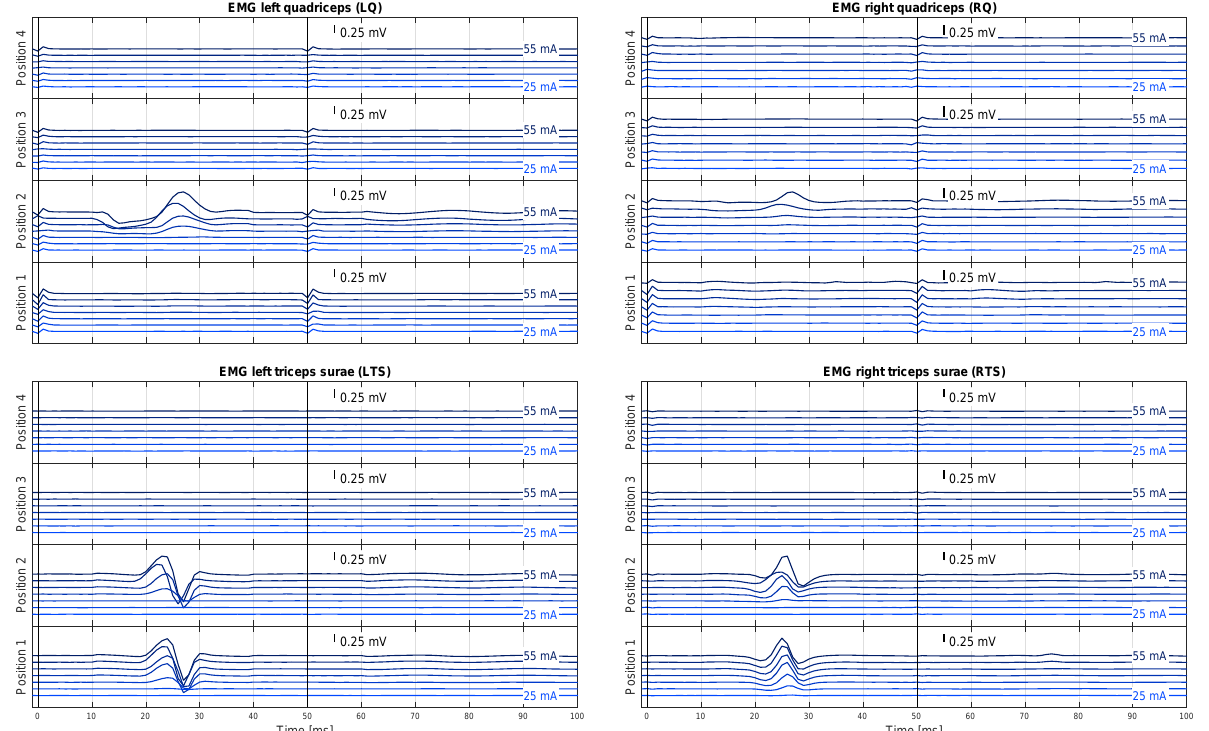
Figure 4. EMG recordings derived from bilateral quadriceps and triceps surae muscle groups during tSCS applied from different rostrocaudal electrode positions with double-stimuli of incremental amplitudes. Exemplary traces derived from a neurologically intact individual, C1, as they were shown to experts. A step-wise increase in stimulation amplitude resulted in the elicitation of responses in bilateral triceps surae by the first pulse of the double stimuli, yet only when applied from the two caudal electrode positions 1 and 2. Bilateral quadriceps responses were present only with stimulation delivered from position 2, hence the best ranked position. Response suppression when the second pulses of the double stimuli were applied after 50ms identified the responses as reflexes. Each trace averaged from up to three double stimuli per stimulation amplitude; blue-shaded values are stimulation